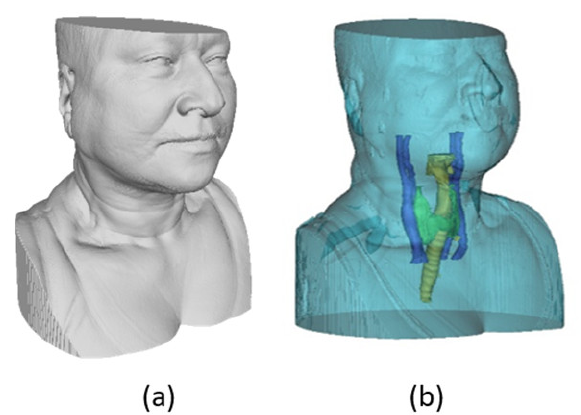
Figure 17. Segmentation results: ( a ) 3D geometry of the bust/neck (outer region only); ( b ) 3D model combined, showing all inner and outer anatomical structures.